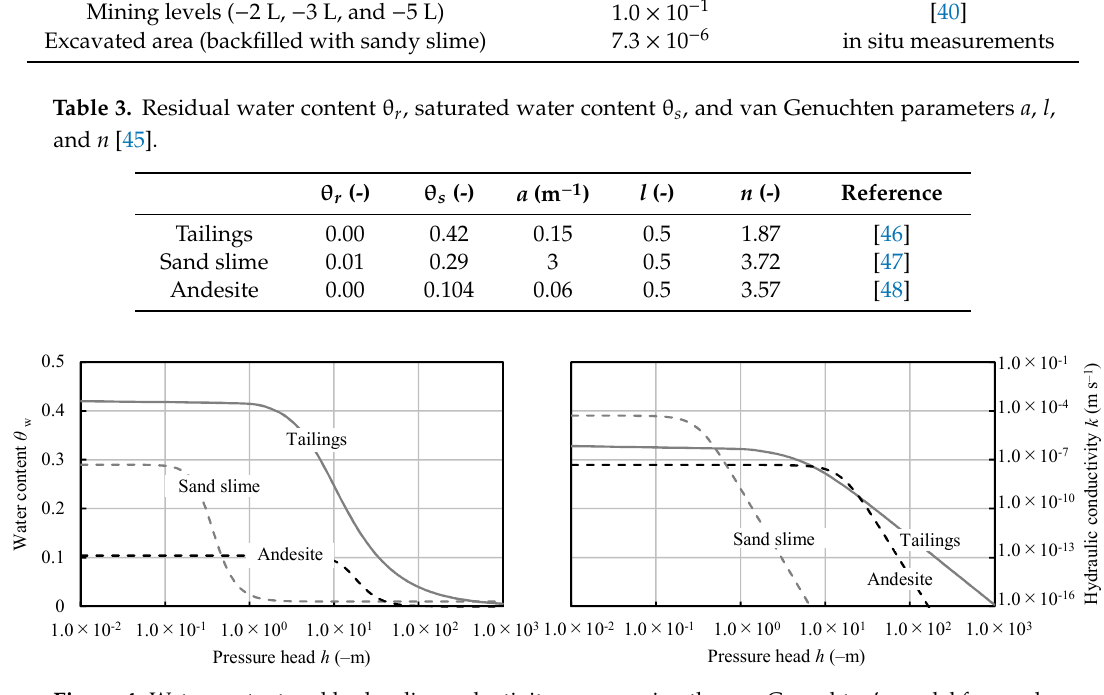
Figure 4. Water content and hydraulic conductivity curves using the van Genuchten’s model for sandy slime, tailings, and andesite. See Table 3 for the corresponding parameters of the van Genuchten model [45].